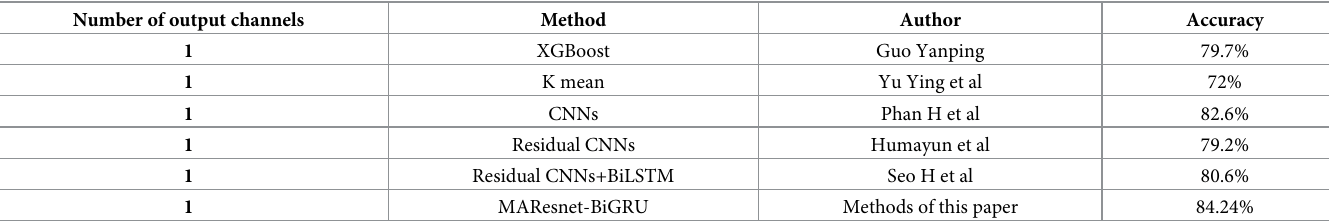
Table 3. The experimental results of Sleep-EDF data set are compared with the existing research